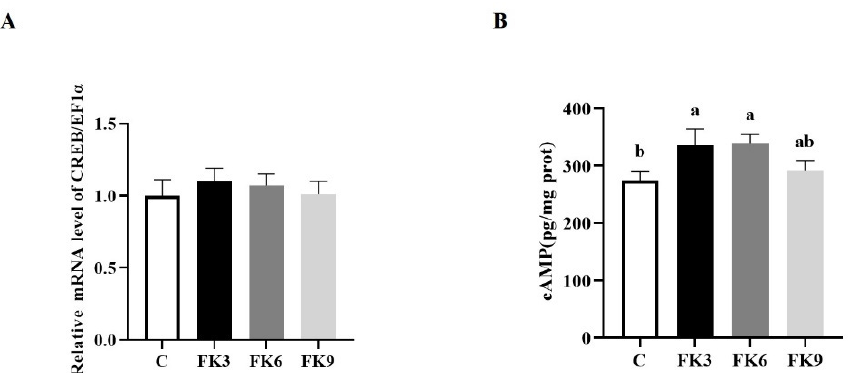
Figure 4. The energy metabolism in distal intestine of largemouth bass fed diets with various FK levels. ( A ) CREB; ( B ) cAMP. Different superscript letters “a” or “b” indicate significant differences ( p < 0.05), whereas the same superscript letters show no significant differences among groups (means ± SEM, n = 12).